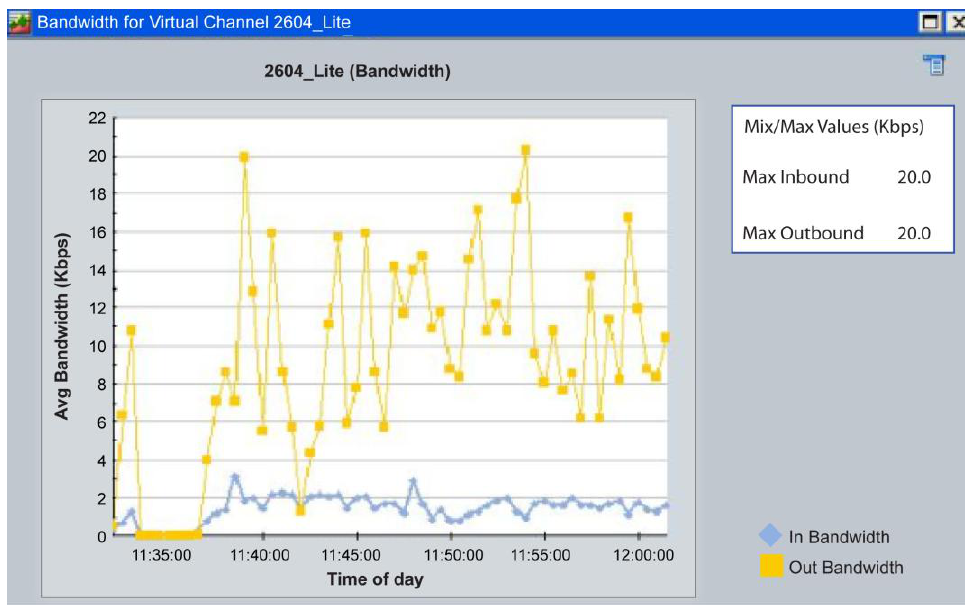
Figure 8. Bandwidth required in a satellite link for transmitting meteorological